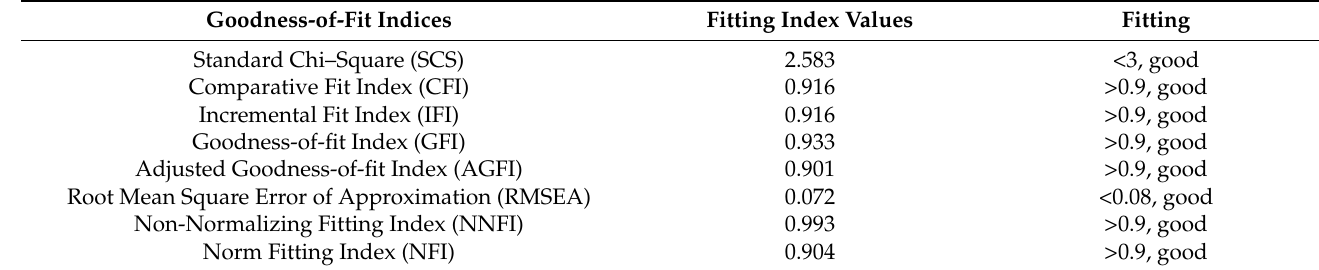
Figure 3. Results of structural equation modeling. Comparative fit index = 0.916; goodness-of-fit index = 0.933; root mean square error of approximation = 0.072; degrees of freedom = 52; chi-square = 374.583. X1–X12 are the scale items codes and e1–e15 are statistical errors of 3 variables and 12 scale items. Table 6. Structural equation modeling fitting.